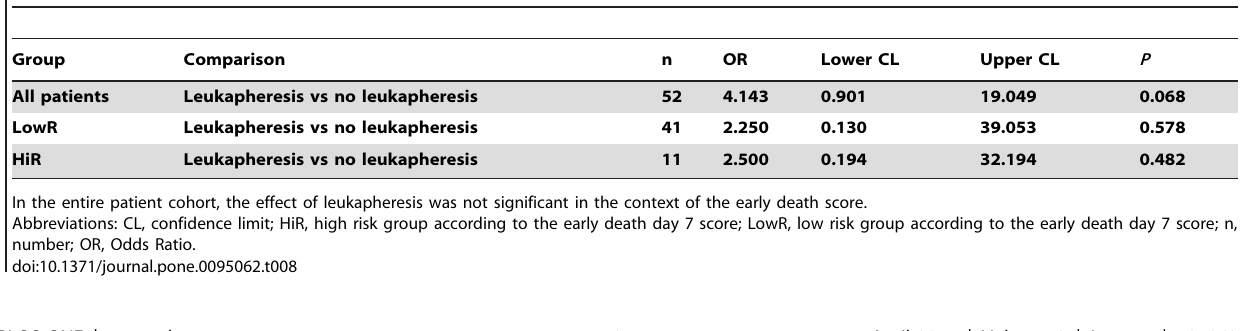
Table 8. Univariate logistic regression for Death within 7 days (ED d7